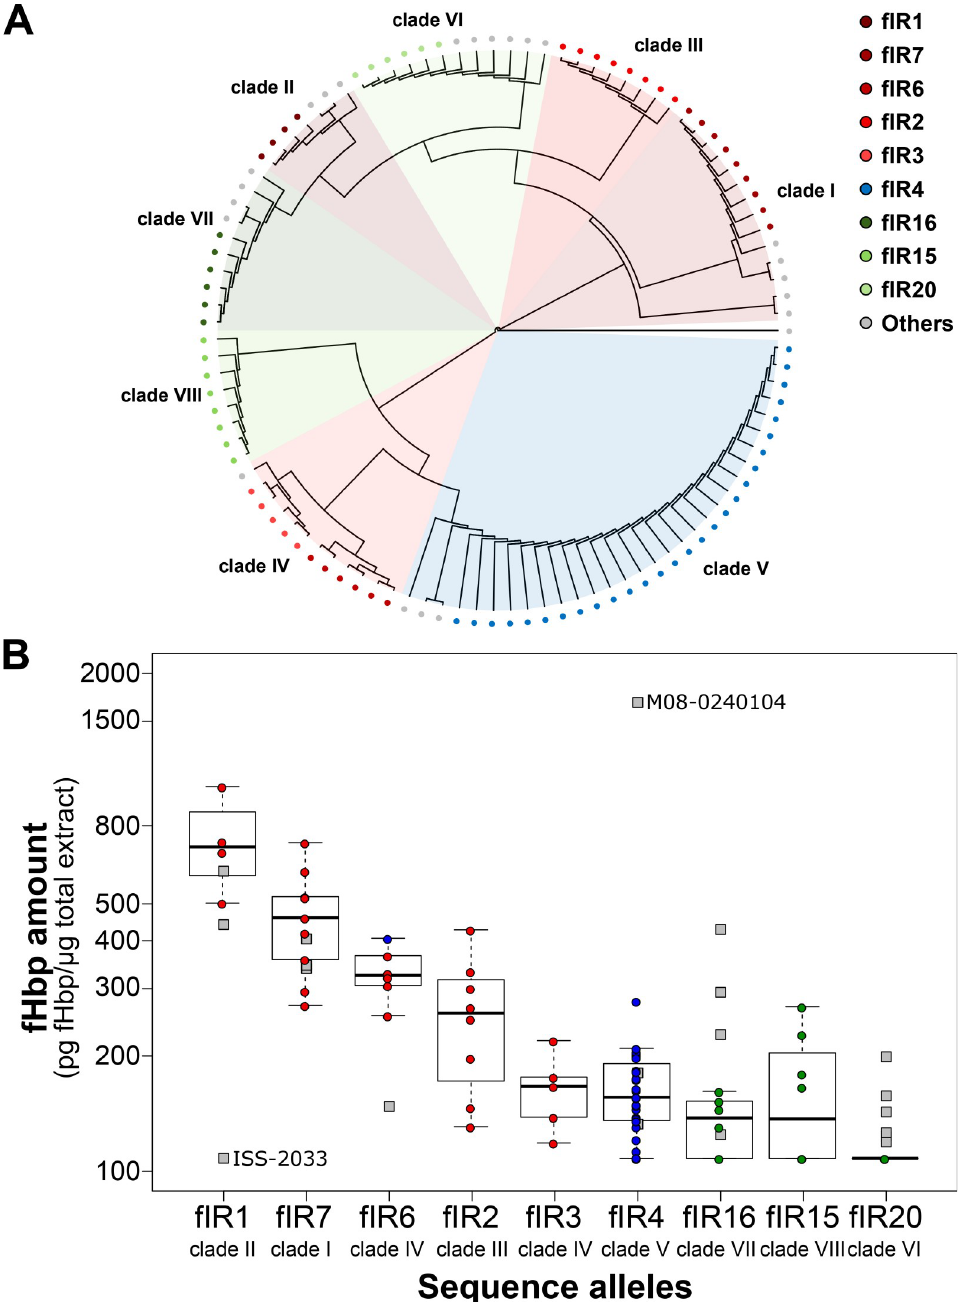
Fig 1. Alleles of the cbbA – fHbp intergenic region (fIR) from 105 strains [26]: variation within promoter clades and resulting expression levels. (A) Phylogenetic tree obtained from the multiple sequence alignment of the fIR of the 105 strains previously investigated in Biagini et al . [26]. Promoter clades from the previous analysis are represented as colored sectors inside the tree: colors of sectors reflect the association with var1, var2, and var3 fHbp as shades of red, blue, and green, respectively. Within each clade the most representative fIR allele(s) are represented as colored dots: shades of red, blue, and green indicating association with var1, var2, and var3 respectively; grey dots indicate fIR alleles other than the most representative. (B) Box plots showing the distribution of Selected Reaction Monitoring (SRM)-MS fHbp quantification values of different strains (previously measured and reported in [26]) clustered by major fIR sequence alleles within each clade and ordered from highest to lowest mean fHbp protein values. The Y axis is in logarithmic scale. The median fHbp protein value for each group is indicated by thick bars, the interquartile range is delimited by each box, and the 95% frequency intervals of SRM-MS values are marked by the whiskers.